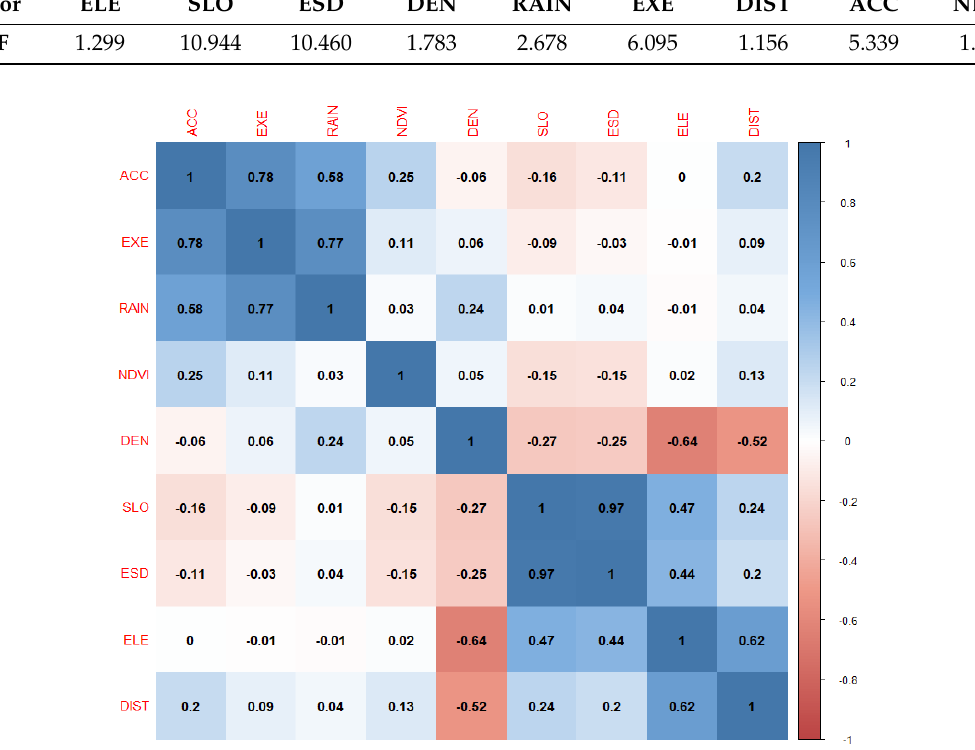
Table 3. Variance inflation factor. Table 4. Variance inflation factor after factor selection.